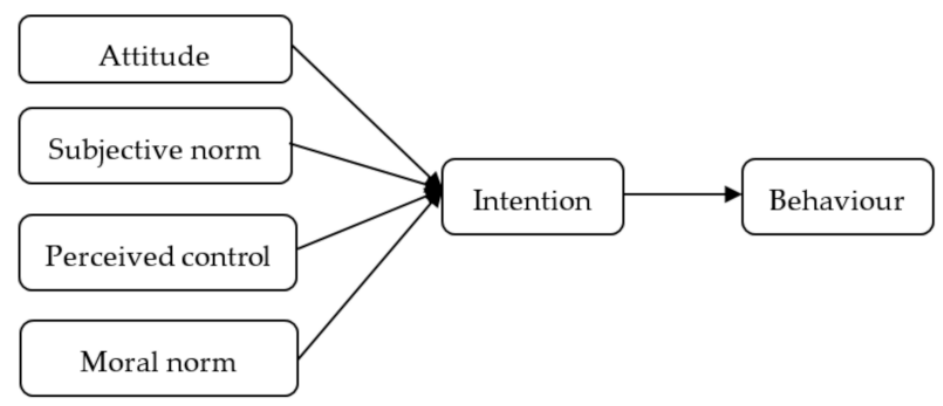
Figure 2. The modified TPB conceptual